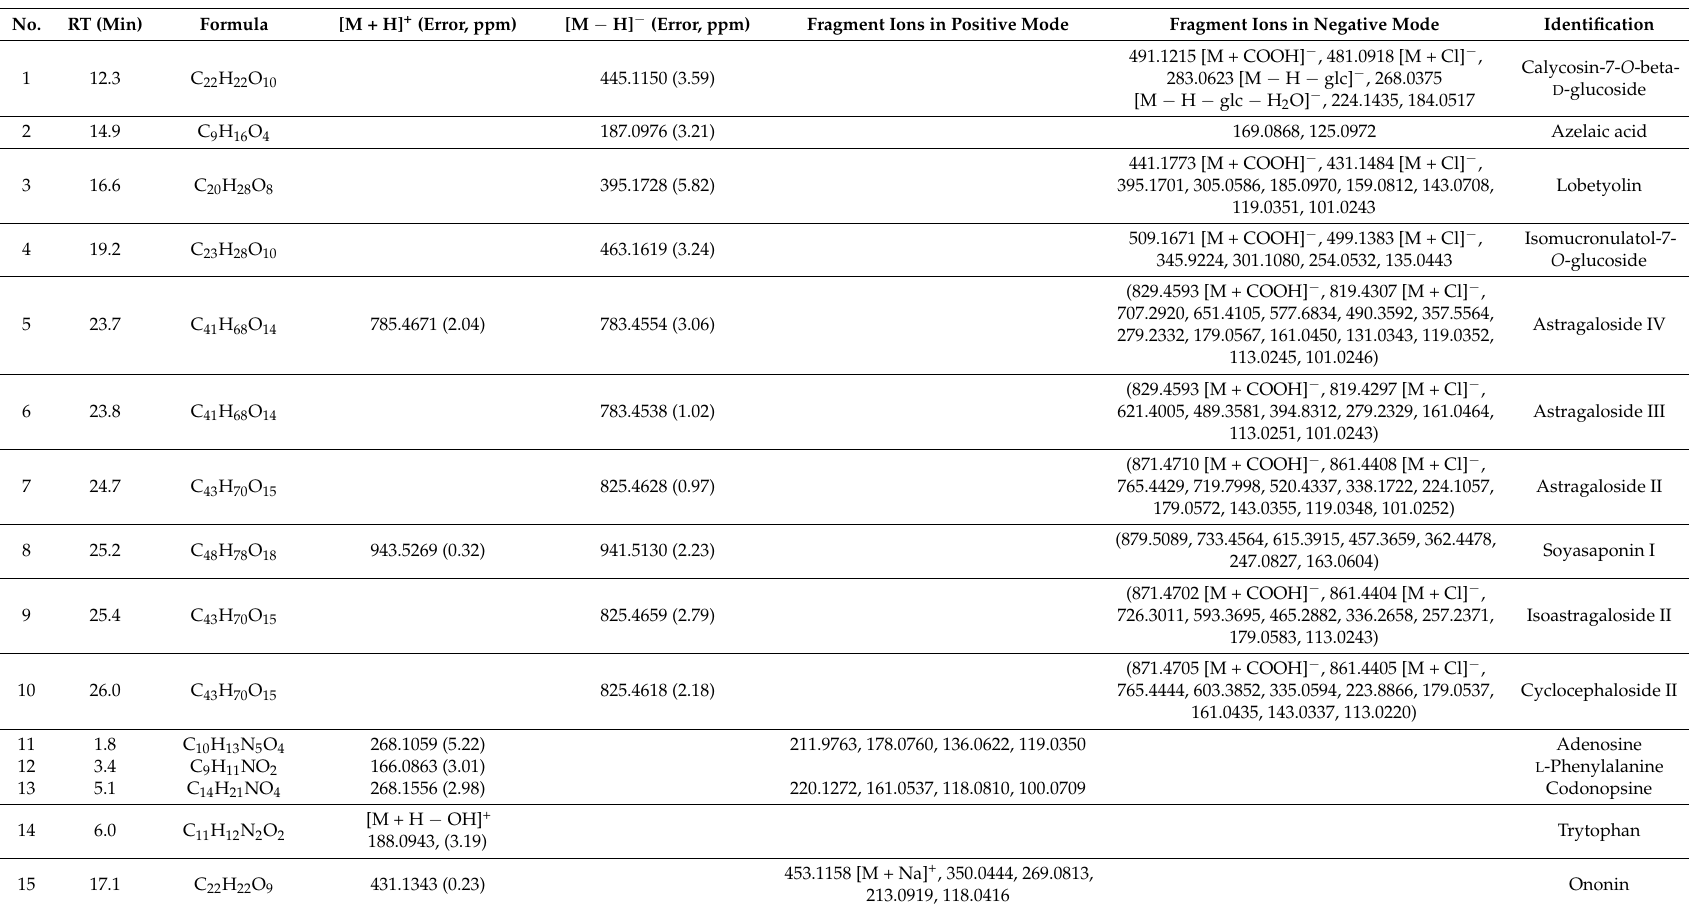
Table 1. Identification of chemical constituents of SQ injection by UPLC-MS in positive and